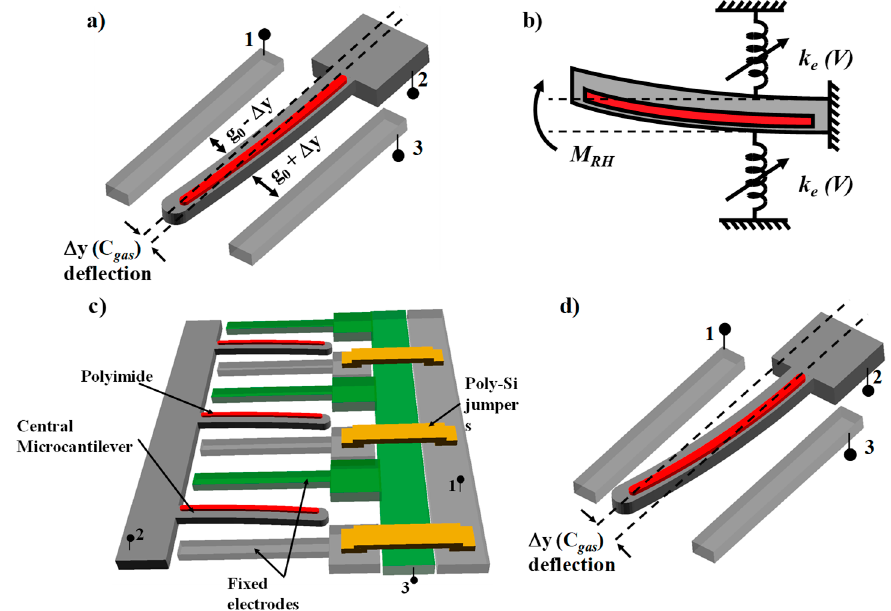
Figure 1. ( a ) Unit cell of the LACM humidity sensor. ( b ) Mechanical equivalent of the device when subjected to a change in relative humidity. ( c ) Array structure of parallel LACM unit cells. ( d ) Use of parametric amplification to magnify the deflection sensitivity of the central microcantilever.